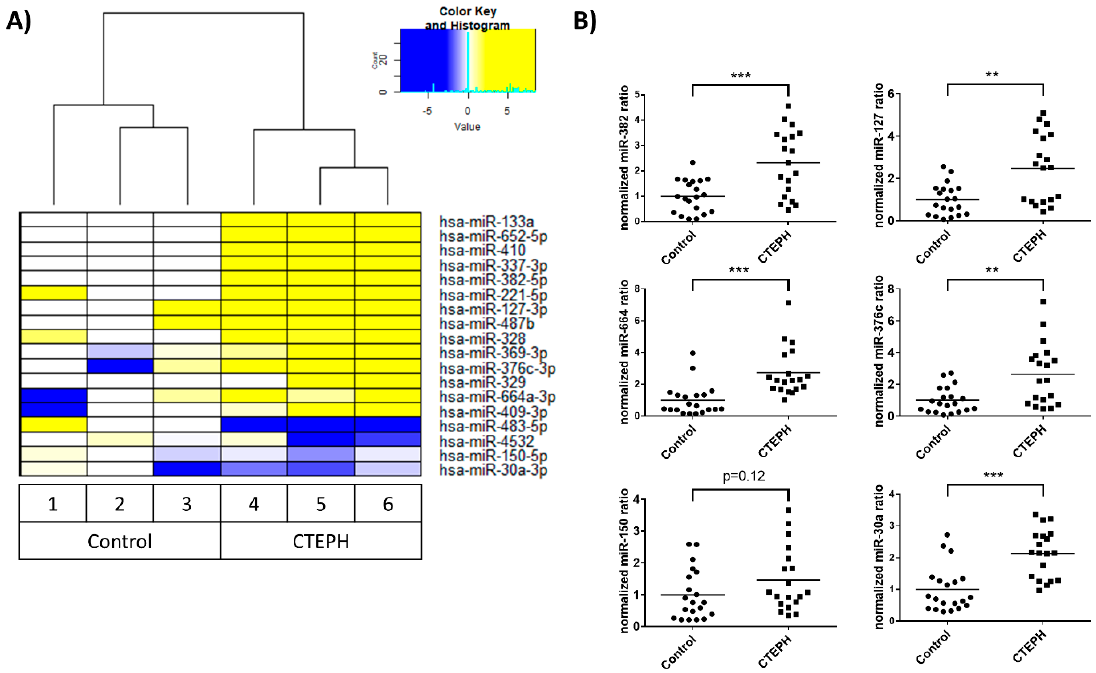
Figure 2. Differentially regulated EV-associated miRNAs in chronic thromboembolic pulmonary hypertension (CTEPH) vs. control individuals. EV- associated miRNAs were isolated using the exoRNeasy protocol. ( A ) RNA sequencing (n = 3) was performed using TrueQuant technology followed by sequencing. Depicted is the log 2 (fold change) of the samples compared with the median of the controls. ( B ) miRNA abundance was standardized to the spike-in control cel-miR-39 and compared with that of healthy controls. The mean of the individual groups is depicted as a line. Significance was calculated using Student’s t -test with Welch’s correction. * p < 0.05, ** p < 0.01, *** p < 0.001.